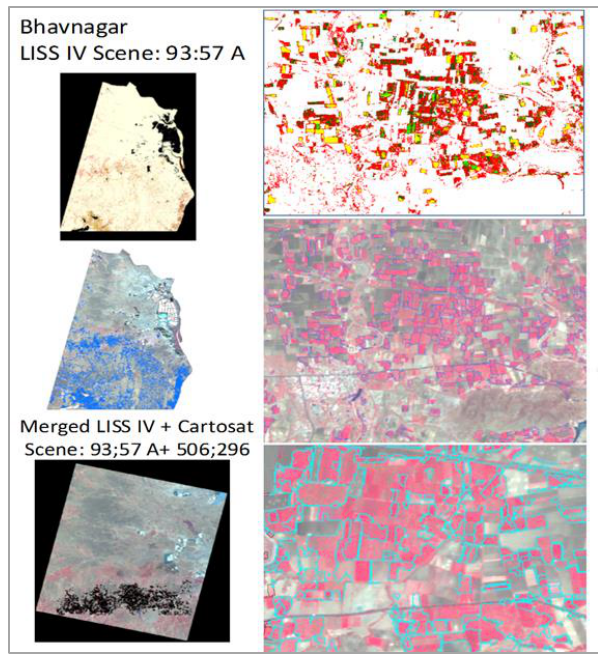
Figure 10. Orchard classification using merged product of LISS – IV and CARTOSAT-2